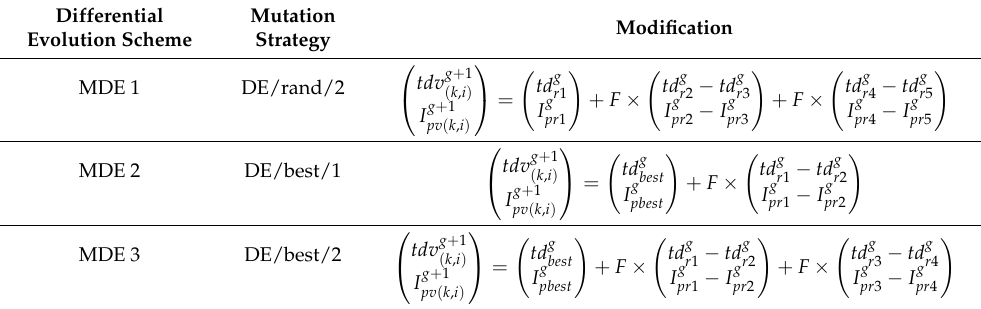
Table 1. Differential Evolution Algorithm Modified